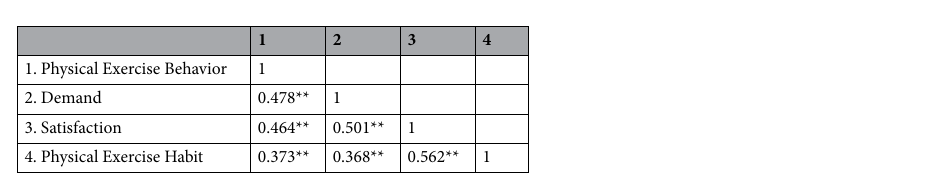
Table 4. The correlations among variables.